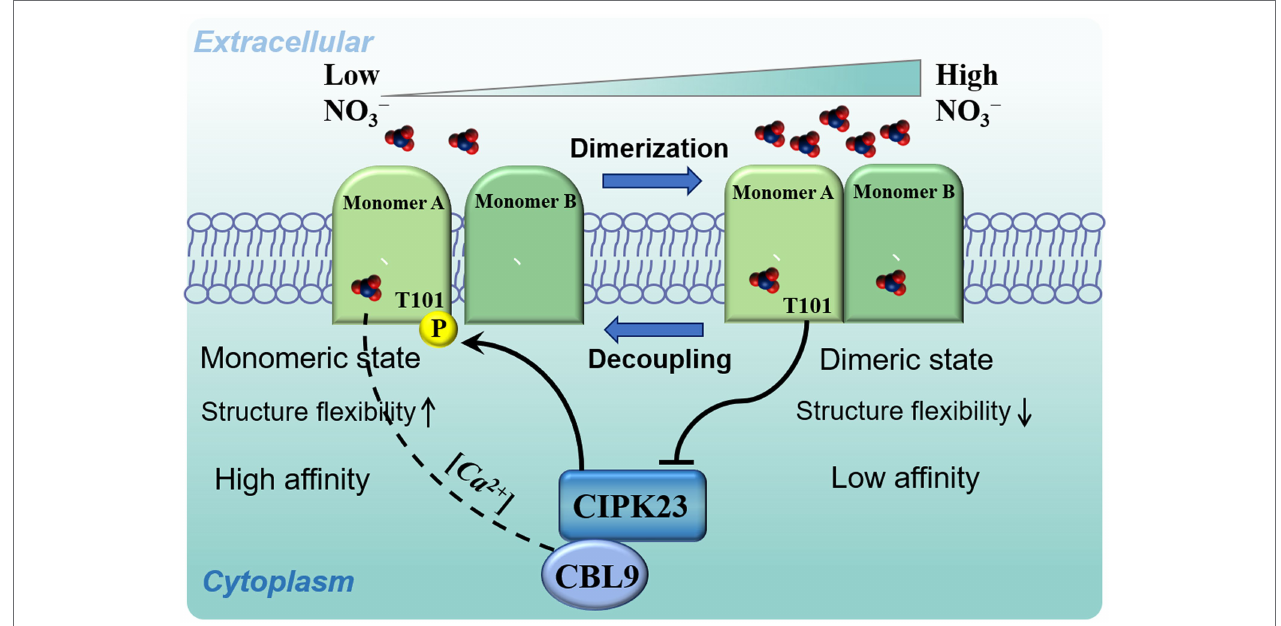
FIGURE 1 | A model of NRT1.1-mediated biphasic control of nitrate signalling and transport. At low nitrate concentrations, nitrate binds only at the high-affinity site of monomer A, which induces asynchronous motions that initiate NRT1.1 dimer decoupling and priming of the Thr101 site for phosphorylation by the interactions with the CBL9-activated kinase, CIPK23. This phosphorylation eventually establishes a stable monomeric state of NRT1.1, which acts as a high-affinity nitrate transceptor. At high nitrate concentrations, nitrate binds to both monomers, which maintains synchronous motions that retain the dimeric state of NRT1.1 by attenuating the activity of the kinase, CIPK23, thereby regulating low-affinity nitrate signalling and